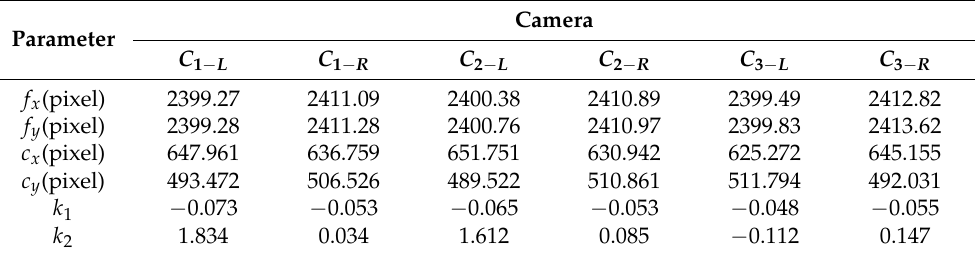
Table 1. Intrinsic parameters determined by planar target.